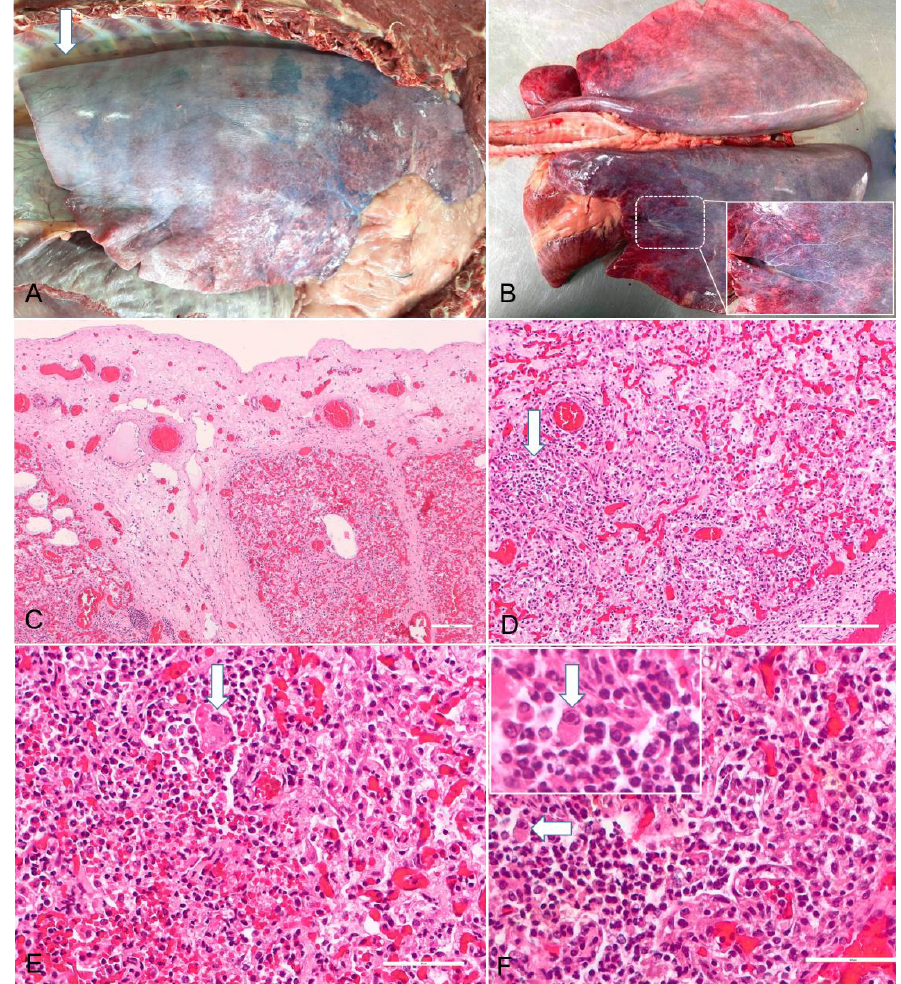
Figure 1. Pathological findings of herpesviral bronchointerstitial pneumonia in a donkey. ( A ) The pleural cavity showing a moderate amount of clear fluid (arrow); ( B ) the lungs failed to collapse after opening the thorax and showed a diffuse rubbery – firm texture with prominent rib imprints, and subpleural and interstitial edema with lymphangiectasia (demarcated area and higher magnification in the inset); ( C ) severe congestion, subpleural and interstitial edema with lymphang- iectasia. HE stain, Bar = 50 µ m; ( D ) necrotizing and neutrophilic bronchiolitis (arrow). HE stain, Bar = 50 µ m; ( E ) epithelial syncytial cells (arrow). HE stain, Bar = 20 µ m; ( F ) intranuclear viral inclusion bodies (Cowdry A type) in the bronchiolar epithelium (arrow). HE stain, Bar = 20 µ m; inset showing the intranuclear inclusion body at higher magnification. HE